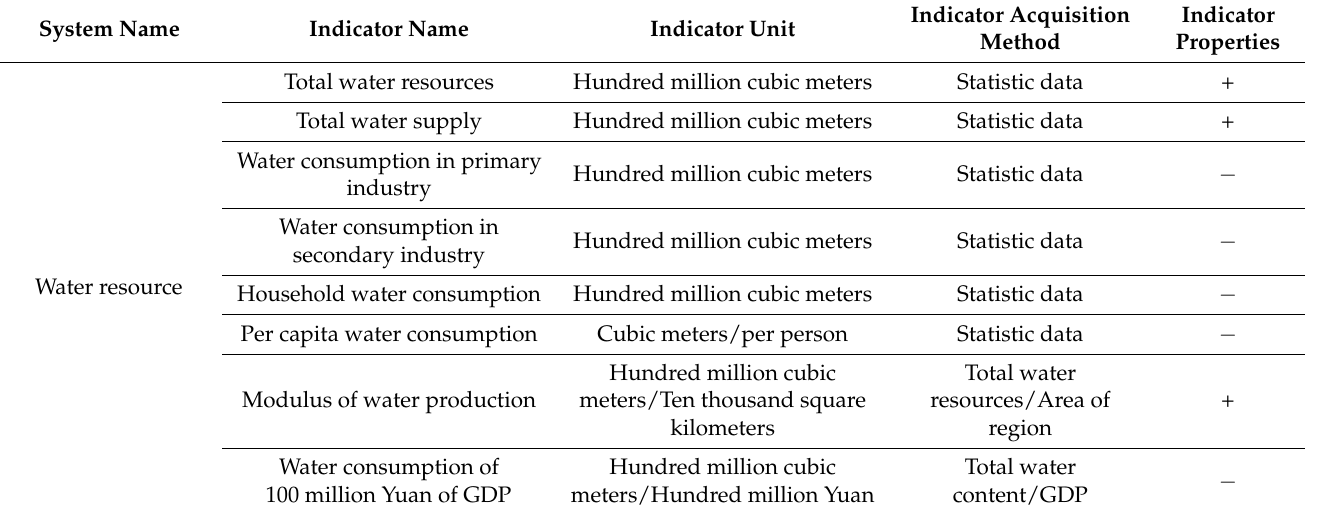
Table 1. Index system of water–energy–cotton system in Tarim River